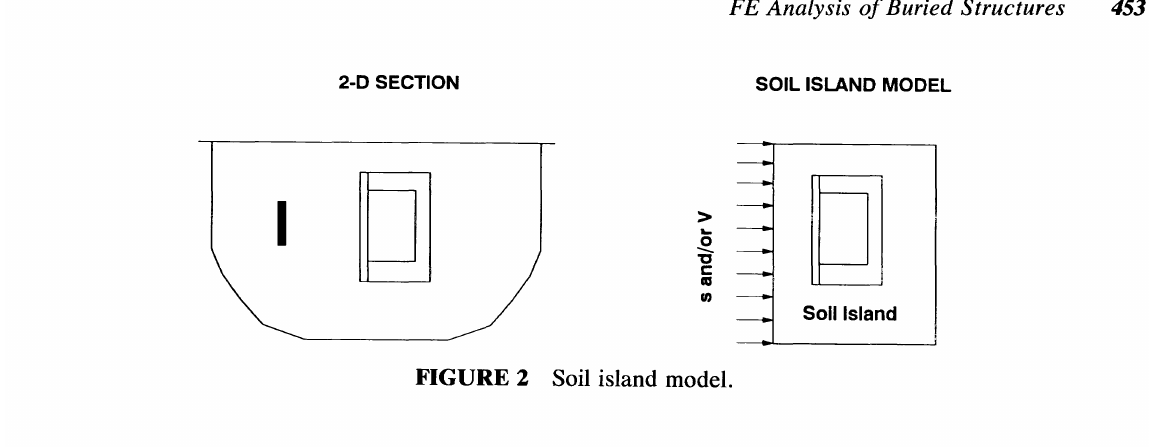
FIGURE 2 Soil island